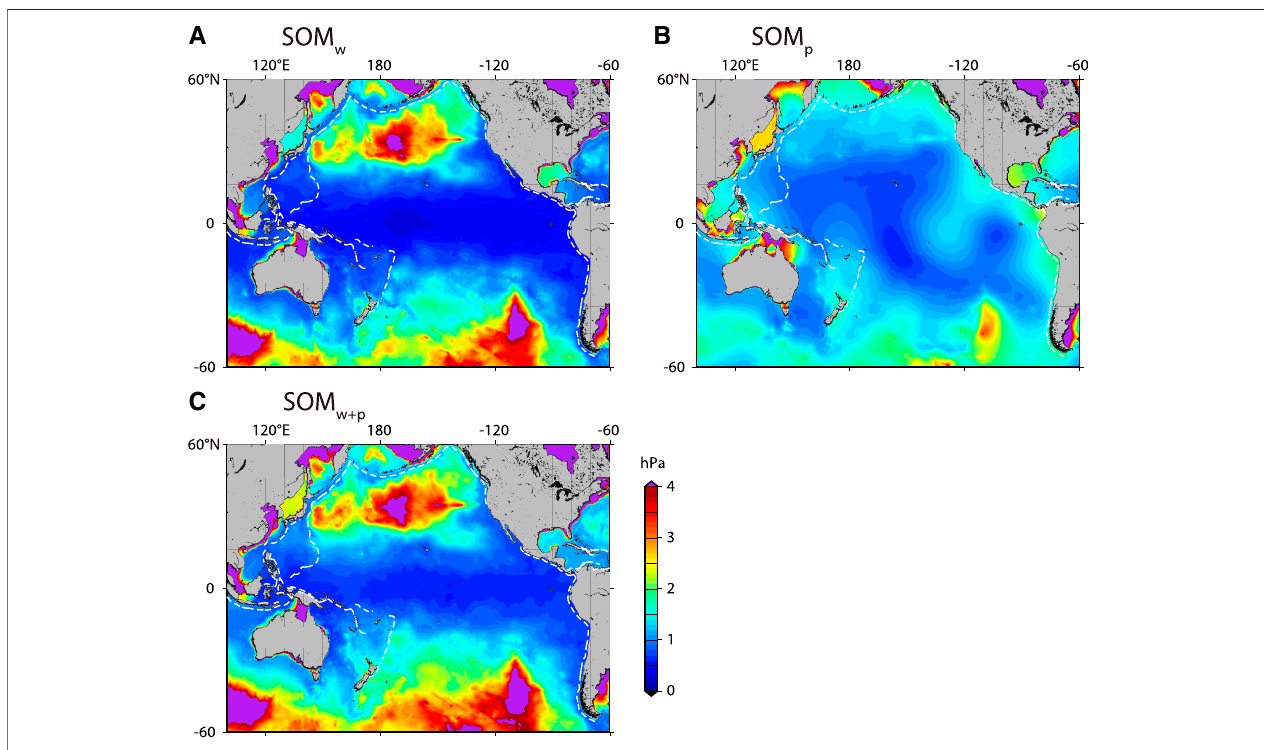
FIGURE3| Root-mean-squareamplitudesofcalculatedoceanbottompressureinSOMdrivenby (A) windalone, (B) airpressurealone,and (C) bothwindandair pressure.